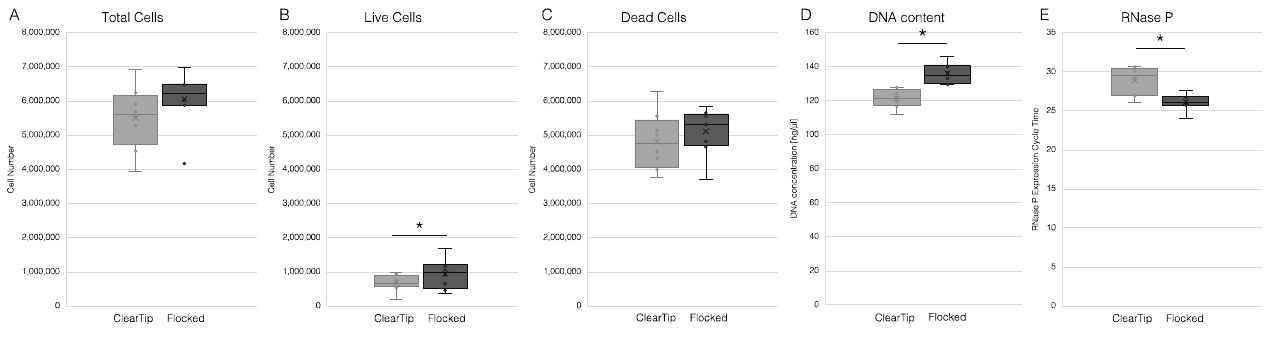
Figure 3. ClearTip TM Preclinical self-sampling validation. Pre-clinical self-sampling study was performed to compare performance of ClearTip TM swab against flocked swab. In this study, numbers of total cells ( A ), live cells ( B ), and dead cells ( C ) were quantified, as well as DNA content ( D ) and RNase P expression ( E ). * Statistically significant differences were only reported for live cells, DNA content and RNase P ( p < 0.05).